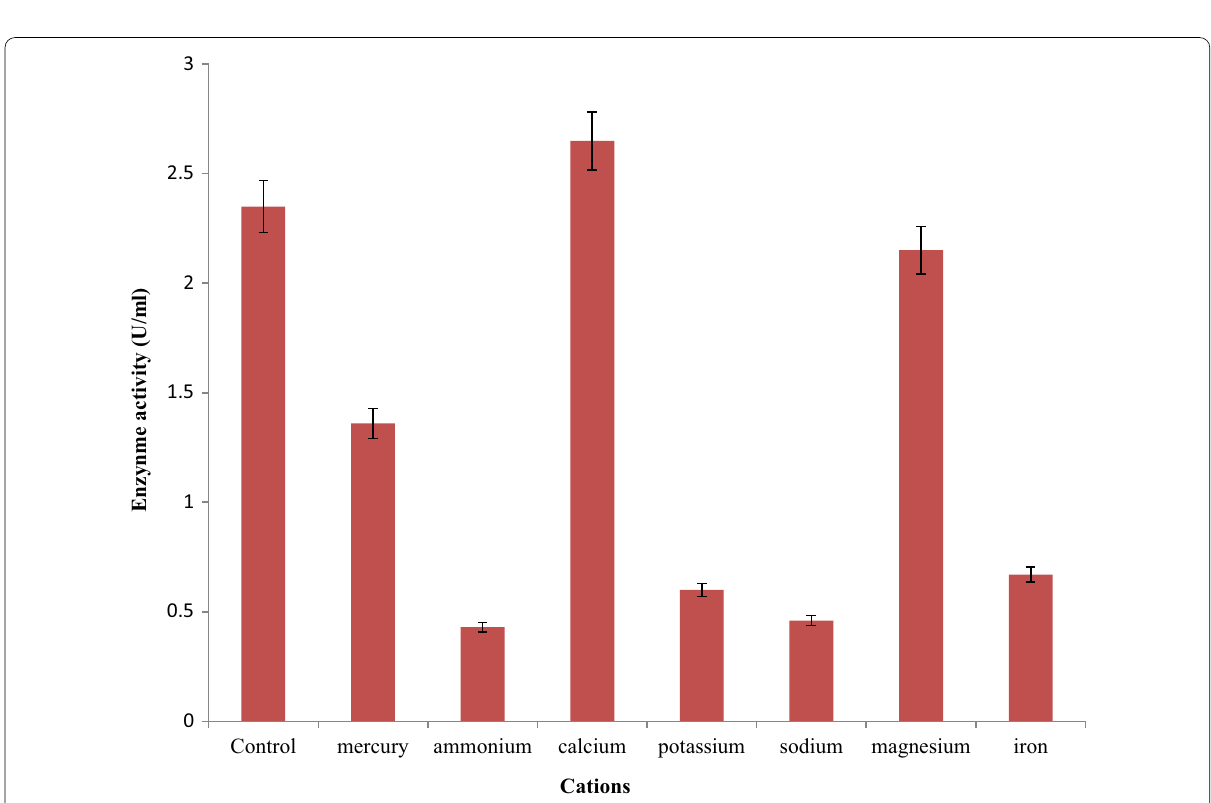
Fig. 8 Effect of different cations on linamarase activity of L.